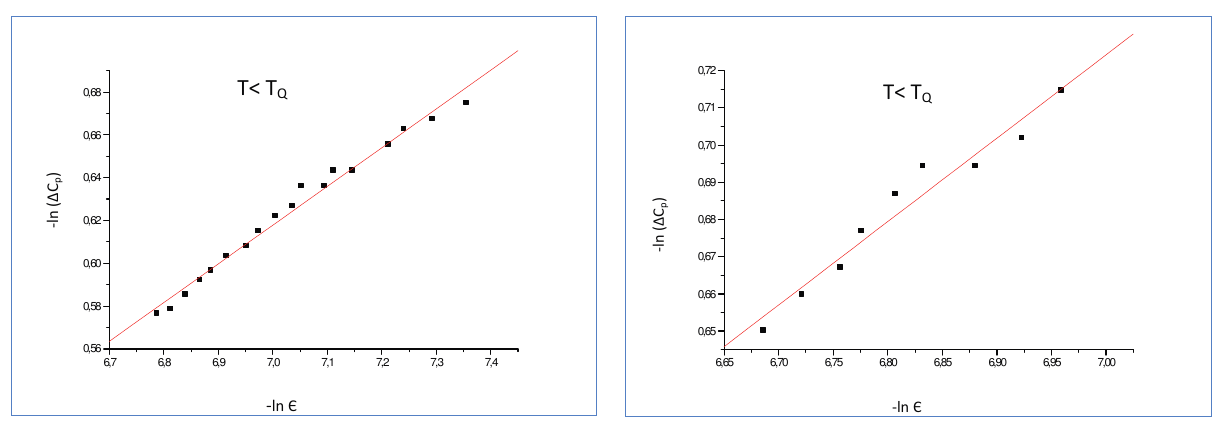
Figure 5. The specific heat (cid:3)C P as a function of the re- duced temperature ( (cid:4) D j T (cid:2) T Q j =T Q ) below the transi- tion temperature ( T Q D 577:1 ı C) for the ˛ - ˇ transition in quartz according to Eq. (2). The specific heat C P data [2] was analyzed along the heating curve (see Table 2).